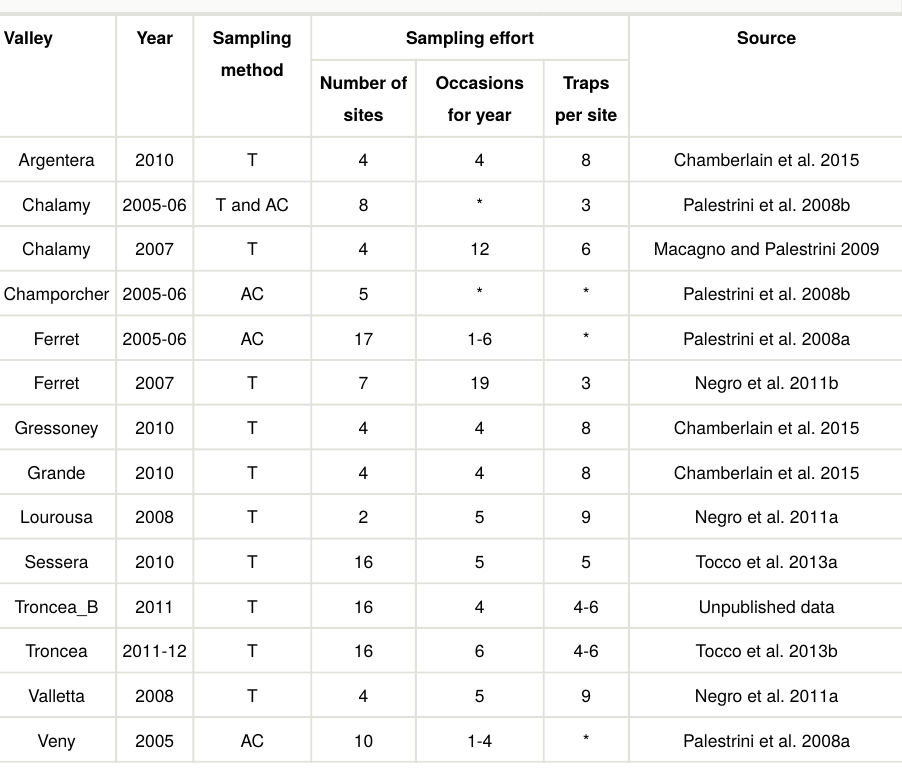
Sampling e ff ort details of the fourteen surveys carried out in eleven valleys of the western Italian Alps from 2005 to 2012. T = Trapping; AC = Active manual collection; * = data unavailable .